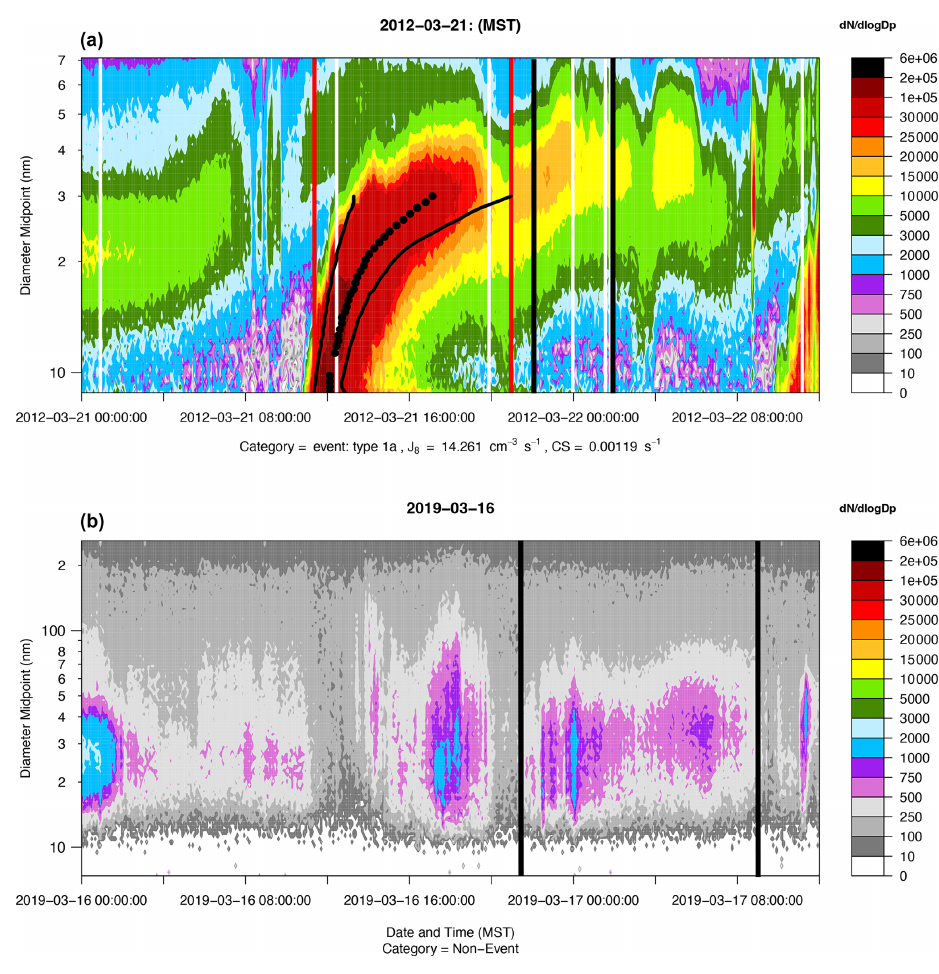
Figure 3. Strong NPF event (a) with midpoint size bin maxima (black points) outlined by the first-order derivative of the fitted distribution at each size (black sloped lines). The vertical red lines denote the initiation and end times of a given event as assigned by the automatic methodology. A non-event (b) is added for comparison. The vertical black lines represent the time period when CCN is considered (CCN start through CCN end ) which is determined for each individual event day, while the seasonal average of this period is used for comparing CCN during non-event